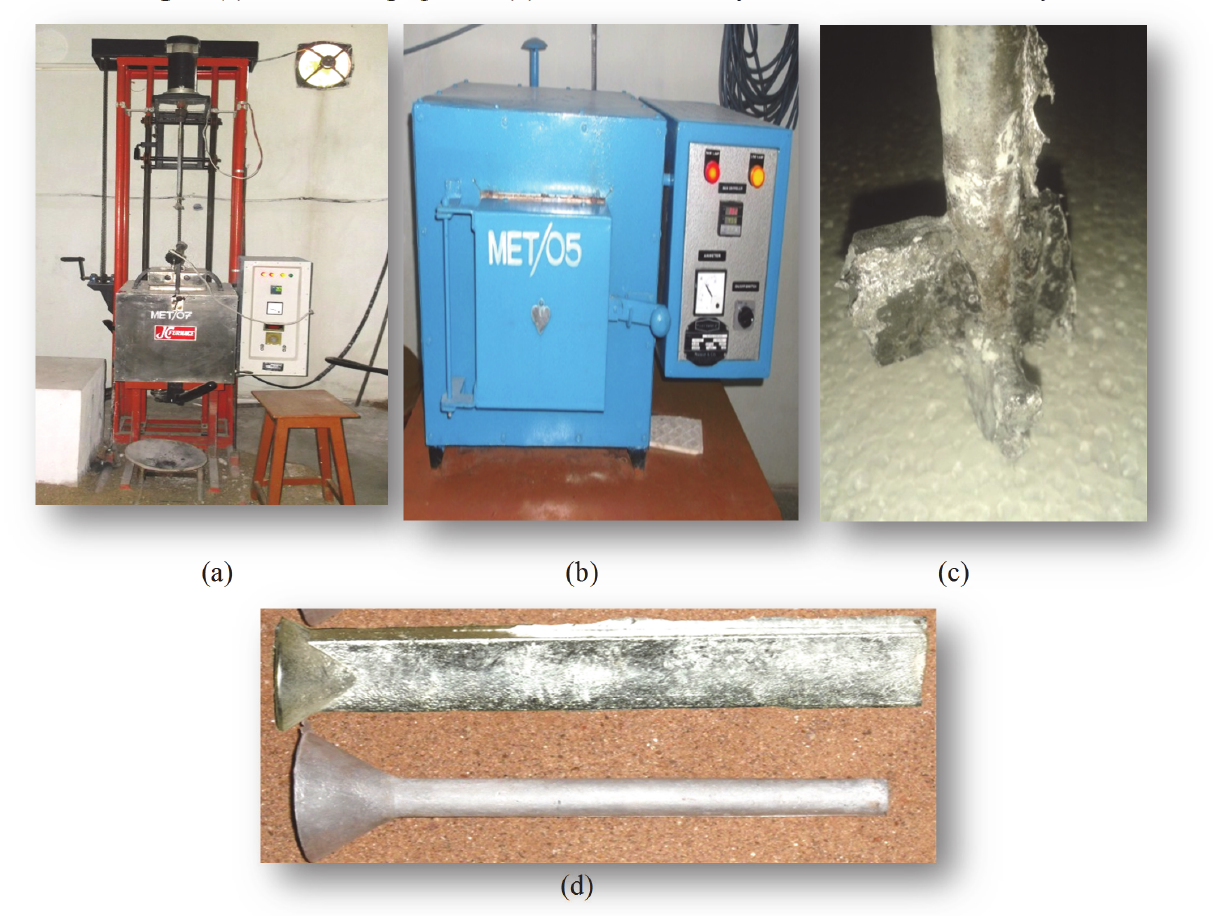
Fig. 2. The components of composite fabrication (a) bottom pouring furnace, (b) muffle furnace, (c) BN coated stainless steel stirrer and (d) cast